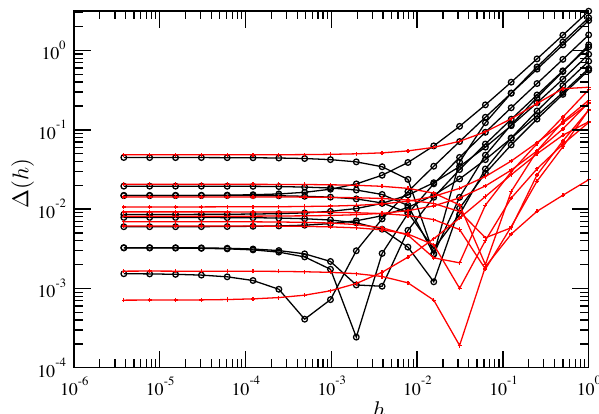
Fig. 6. Ratio 1(h) obtained with the Robin (black curves) and con- Fig. 6. Ratio ∆( h ) obtained with the Robin (black curves) and Control (red curves) inverse methods for perturbations trol (red curves) inverse methods for perturbations of the enhance- of the enhancement factor to the viscosity E η ( x,y ) . ment factor to the viscosity E η (x,y)